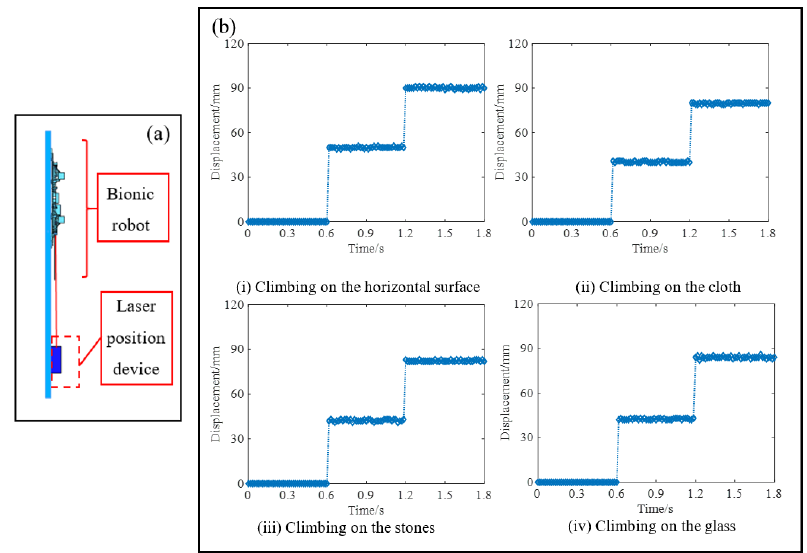
Figure 14. ( a ) Experiment of the locomotion speed of the bionic robot by the laser position device, ( b ) the displacement profile of the robot.